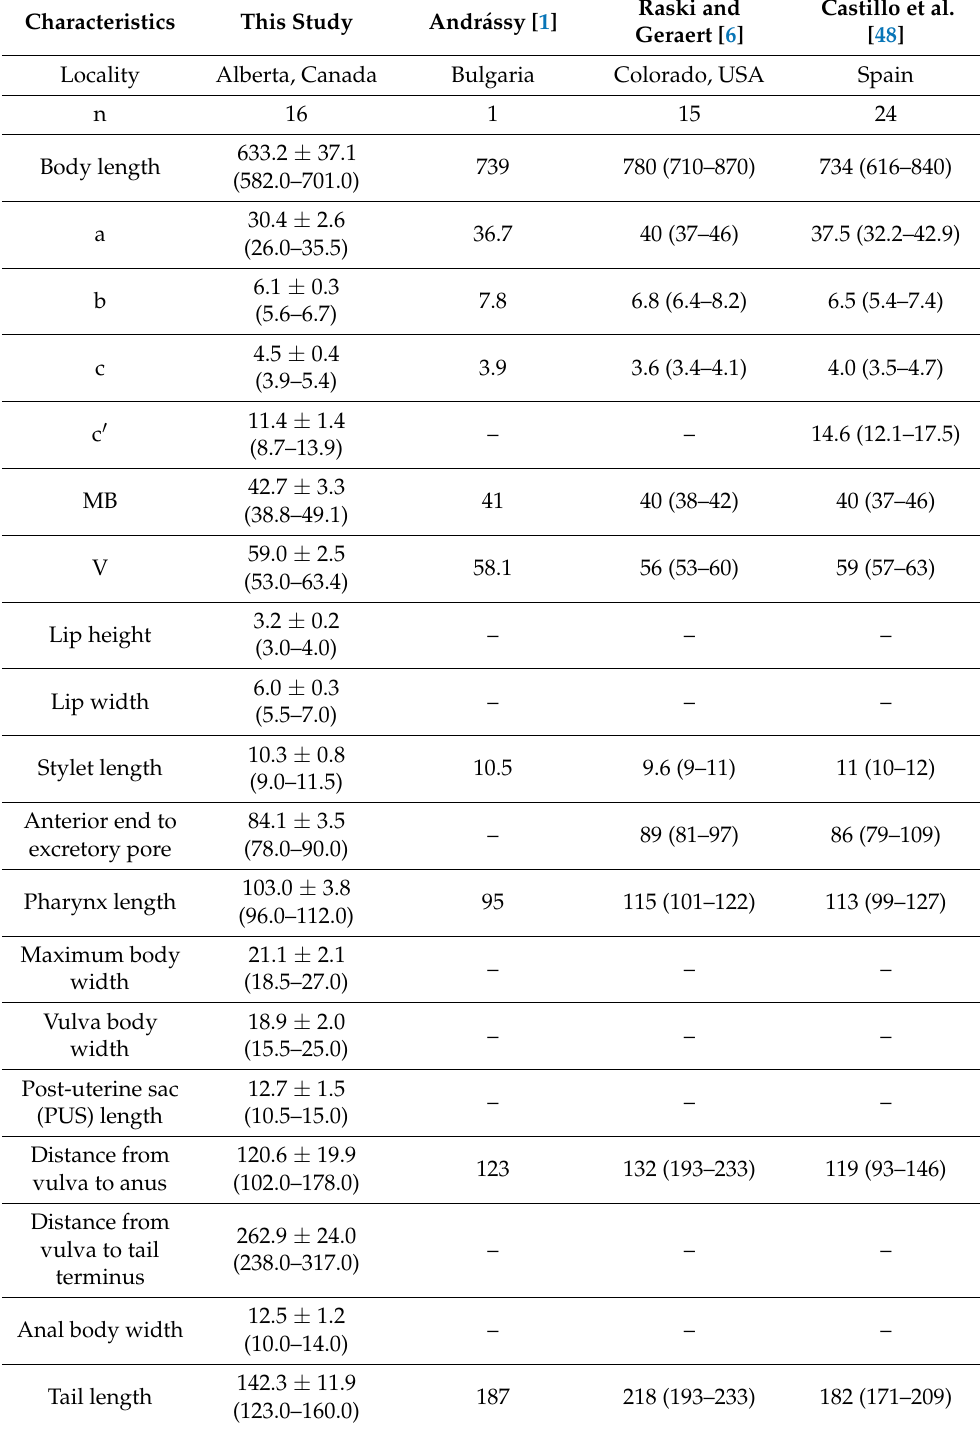
Table 4. Morphometrics of female Filenchus thornei (Andr á ssy) Andr á ssy [1,23] examined in this study and from the original and subsequently published descriptions. All measurements are in µ m and in the form: mean ± standard deviation and/or